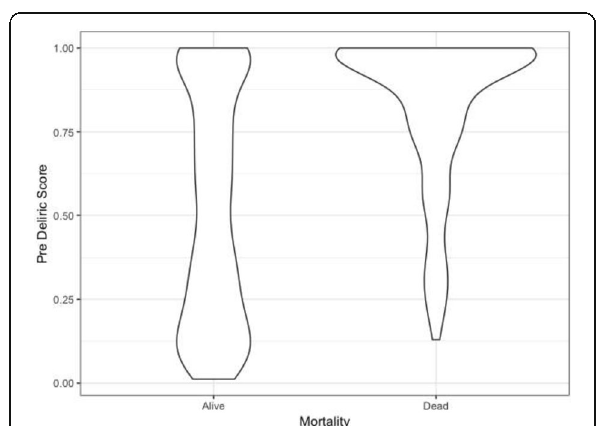
Fig. 1 (abstract 0033). Violin plot of Mortality VS Pre-Deliric Score. PRE-DELIRIC scores were bimodal; the two modes are